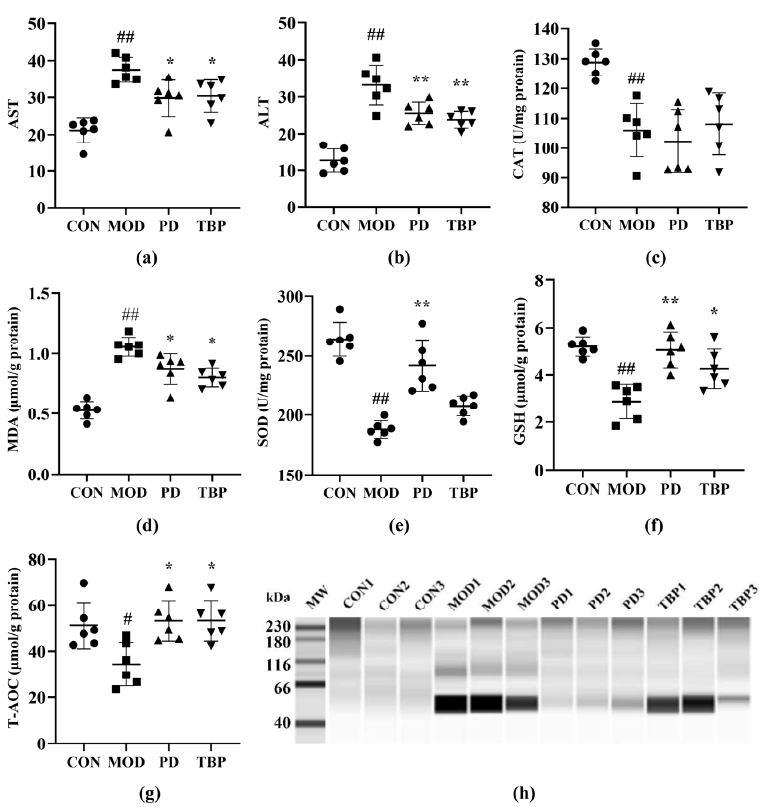
Figure 5. Effect of TBP on serum AST ( a ), serum ALT ( b ), liver CAT ( c ), liver MDA ( d ), liver SOD ( e ), liver GSH ( f ), and liver tT-AOC ( g ) in rats fed a HFD. ( h ) Oxidation levels of carbonyl proteins in rat liver were detected by western blotting ( n = 3). MW, molecular weight marker. Values are expressed as the mean ± SD ( n = 6) for all groups. ## p < 0.01 and # p < 0.05 denote statistically significant differences between the CON and MOD groups. ** p < 0.01 and * p < 0.05 denote statistically significant differences with MOD group.